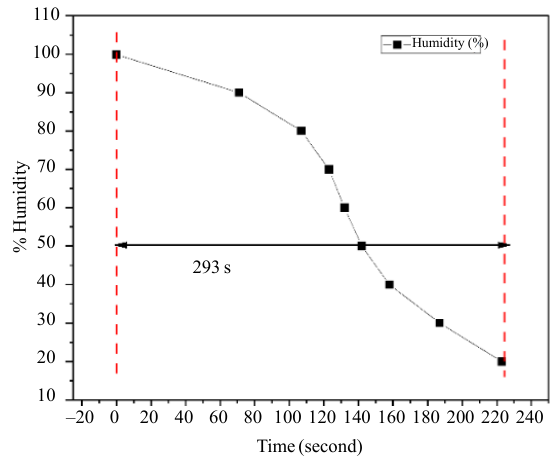
Fig. 14 Recovery time of the